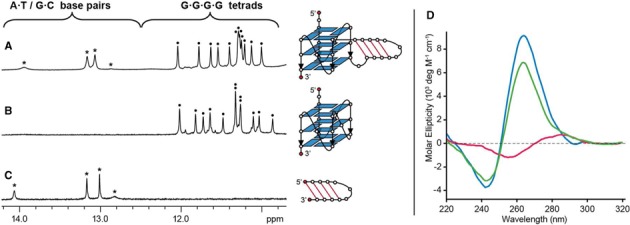
NMR and CD spectra of the ELFN1 gene sequence G4ST07001717478. (A–C) NMR spectra of (a) G4ST07001717478 and its reference (b) quadruplex (G4ST07001717478_G4) and (c) duplex (G4ST07001717478_dx), with their respective schematic structures shown on the right. Quadruplex and duplex imino proton peaks are marked by circles and asterisks, respectively. (D) CD spectra of G4ST07001717478 (green), G4ST07001717478_G4 (blue) and G4ST07001717478_dx (red).